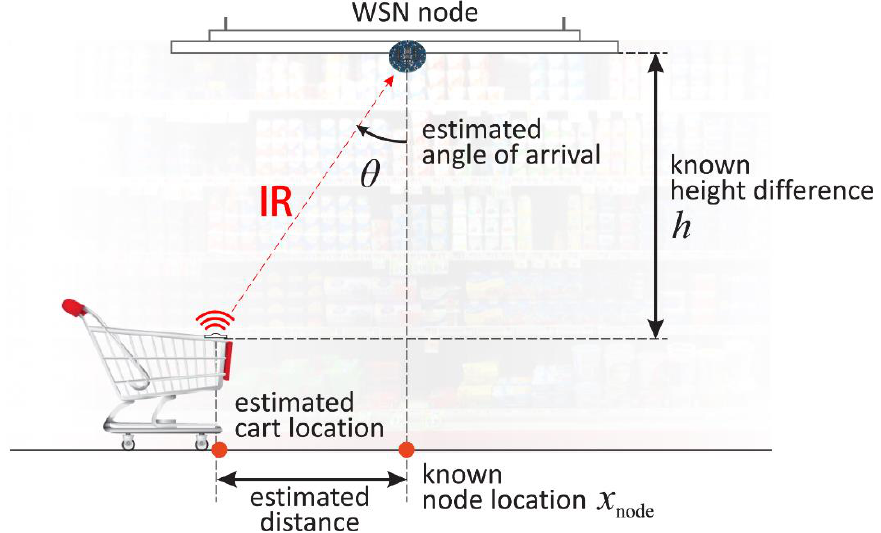
Figure 8. Cart location can be estimated in 1D (along the aisle) using AoA measurement in combination with the prior knowledge of the wireless sensor network (WSN) node location and height difference between node and IR transmitter. In this setup, the AoA sensor is rotated in order to estimate the angle of arrival in the x–z plane. The location of the cart is calculated using an estimated angle, a priori known AoA sensor position, and simple trigonometry relation: x cart = x node + h · tan ( θ )